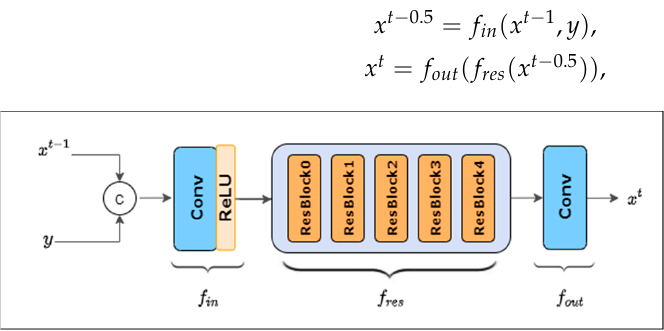
Figure 2. A basic ResNet.